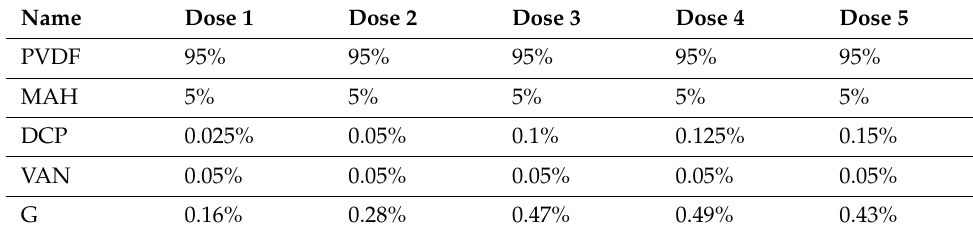
Table 4. A list of the specific compositions used in blending with different DCP contents.